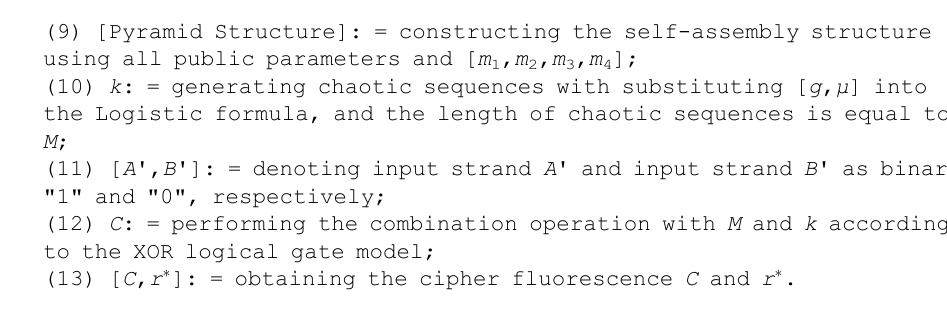
Algorithm 2. The decryption algorithm based on the DNA self- assembly structure operation